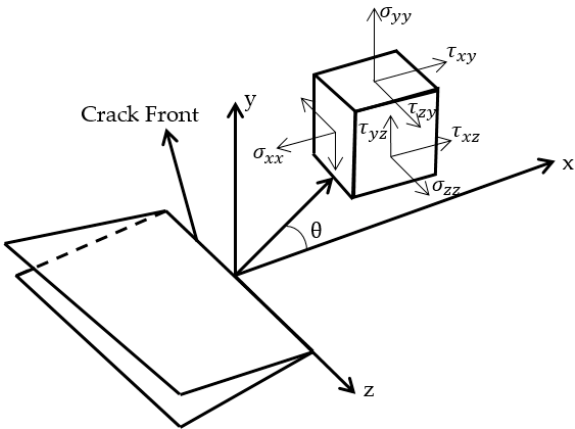
Figure 1. Stress state and polar coordinates system defined at crack front.